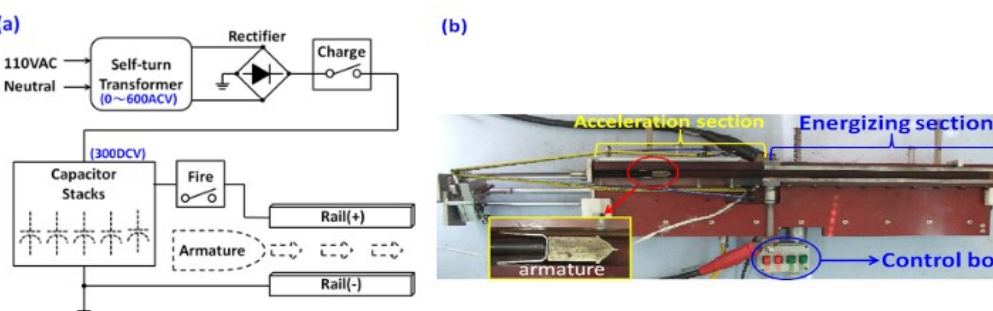
Figure 2. Experimental device ( a ) control circuit; ( b ) electromagnetic rail catapult and